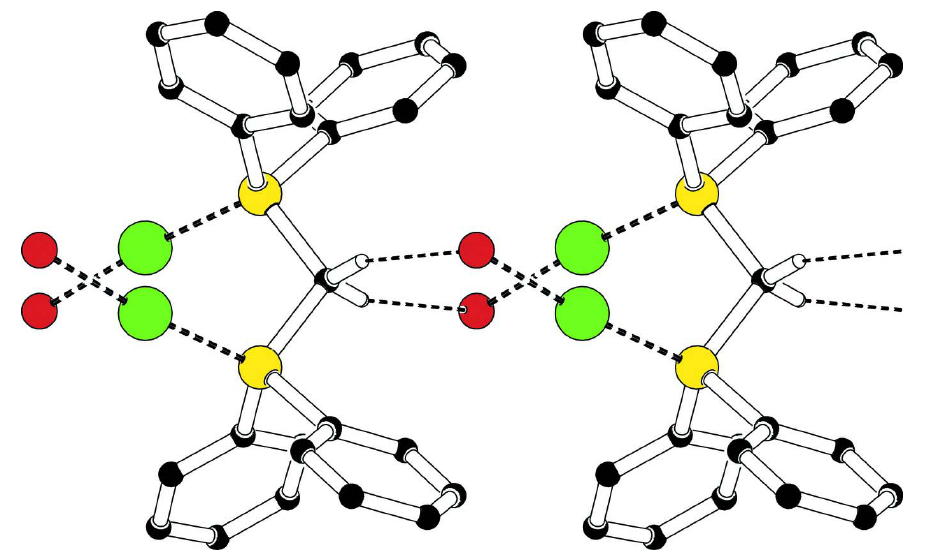
Crystal structure of the title compound depicting the intermolecular hydrogen bonds between H1 A and Cl1 ii (symmetry code: (ii) - x , y + 1, - z + 1/2). The H atoms not involved in hydrogen bonding have been